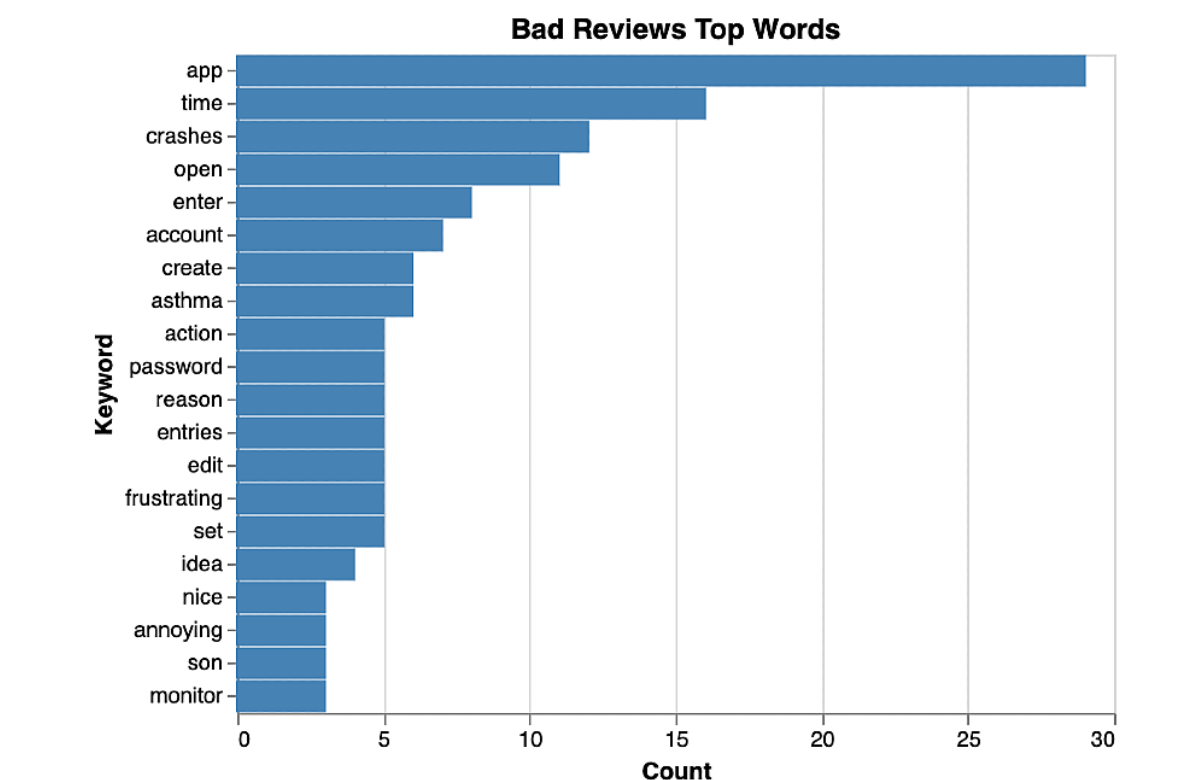
Figure 6. Top words in reviews of poorly rated asthma